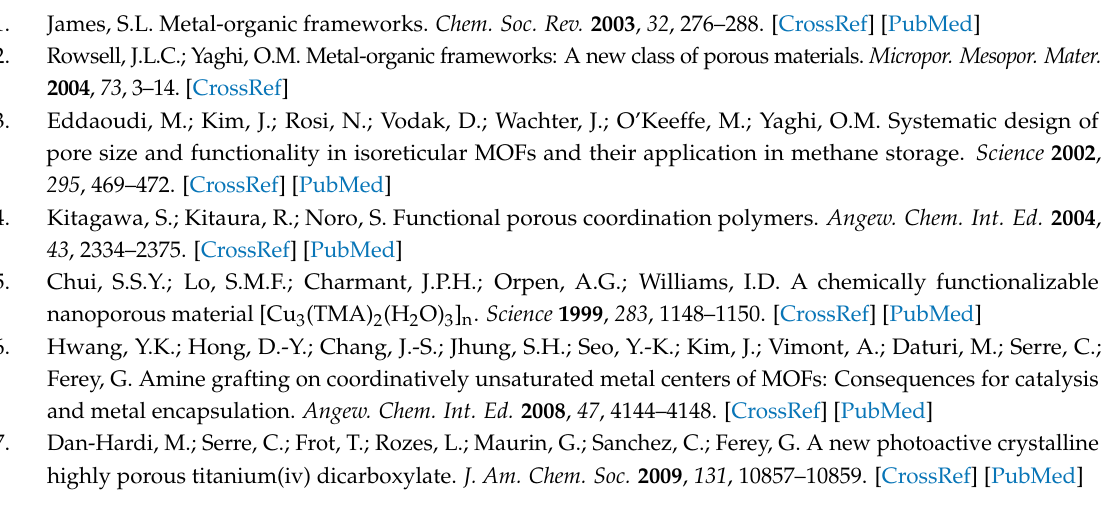
Figure S1: Rate performance ( a ) and cycling performance ( b ) of 1 frame at different temperatures; Figure S2: N 2 adsorption-desorption isotherms of 1 crystals; Figure S3: Ex situ PXRD patterns of the electrochemically active cubic crystals at charge/discharge during the first cycle at a current density of 0.07A · g − 1 ; Figure S4: Ex situ PXRD patterns of the electrochemically active mesoframes at charge/discharge during the first cycle at a current density of 0.07A · g − 1 ; Figure S5: ( a ) SEM of cubic crystals after cycling. ( b ) SEM of mesoframes after cycling for 500 cycles; Figure S6: ( a ) Cyclic voltammetry curves of 1 cube at various scanning rates. ( b ) The anodic and cathodic peak currents as functions of the square root of scanning rates; Figure S7: ( a ) Cyclic voltammetry curves of 1 frame at various scanning rates. ( b ) The anodic and cathodic peak currents as functions of the square root of scanning rates; Figure S8: FT-IR spectrum of mesoframes before electrochemical activation; Figure S9: PXRD patterns of mesoframes before electrochemical